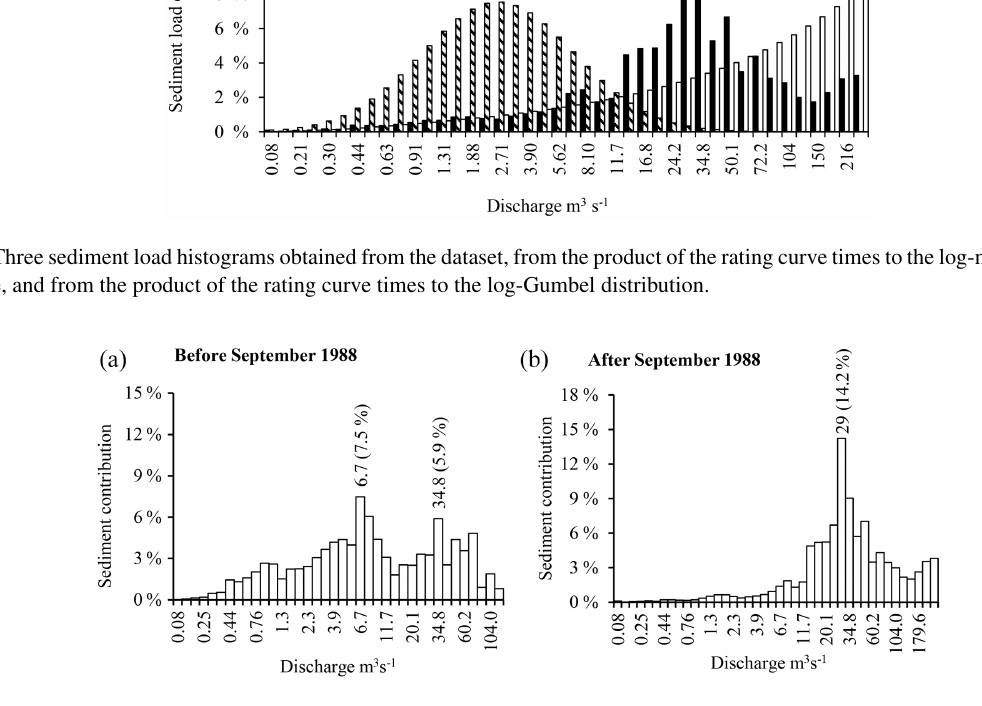
Figure 14. Sediment supply by class for the subdivision in geometric progression: for 1973–1988 (a) and for 1988–2004 (b)